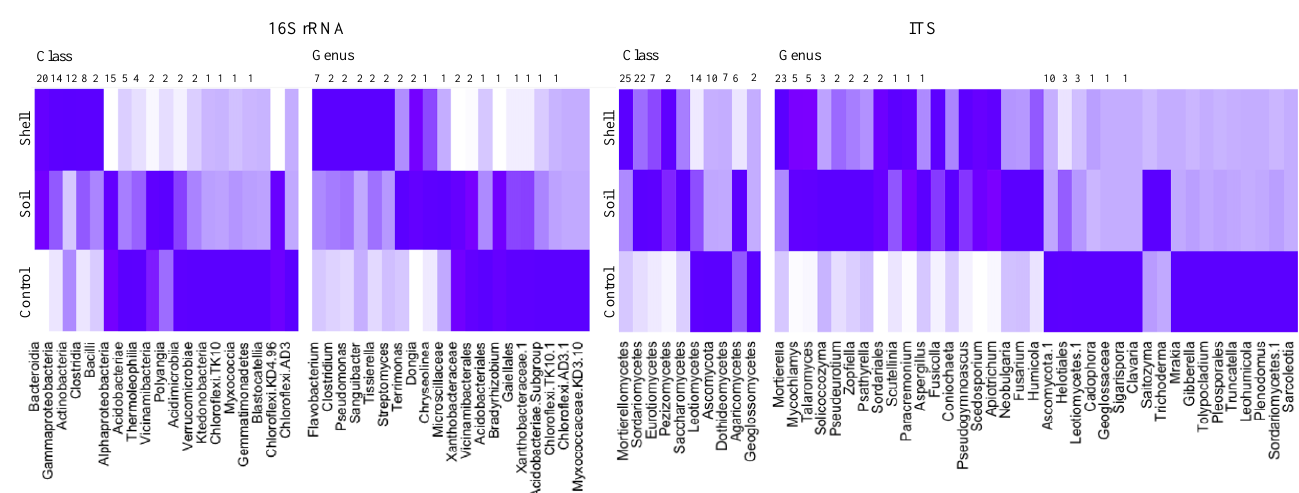
Figure 3. Bacterial and fungal taxa that were differentially represented between Shell, Soil, and Control microbiomes. Based on ALDEx2 Benjamini–Hochberg-corrected p -value of Kruskal–Wallace test.